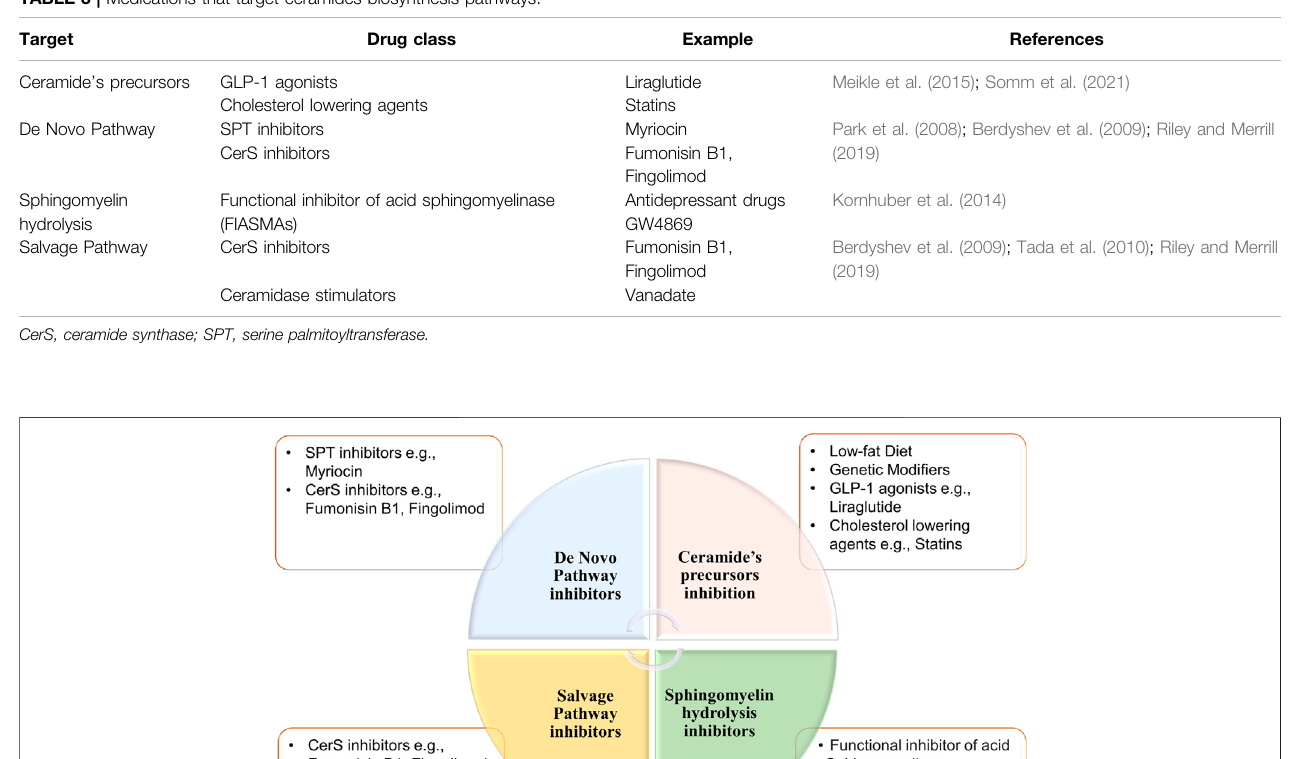
TABLE 3 | Medications that target ceramides biosynthesis pathways.